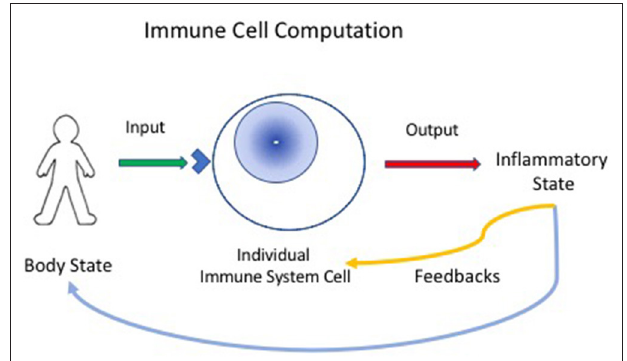
FIGURE 1 | Immune cells compute the state of the body. Individual immune cells bear receptors (blue corner on cell surface), innate receptors or antigen receptors, which are activated by input signals from the body. The individual responding cell, innate, or adaptive, then transforms the input signals into outputs that can mediate inflammatory responses. The inflammatory state then feeds back to heal or protect the body. The immune response also provides feedback to immune system cells and tissues—thus, the immune system organizes itself through experience.